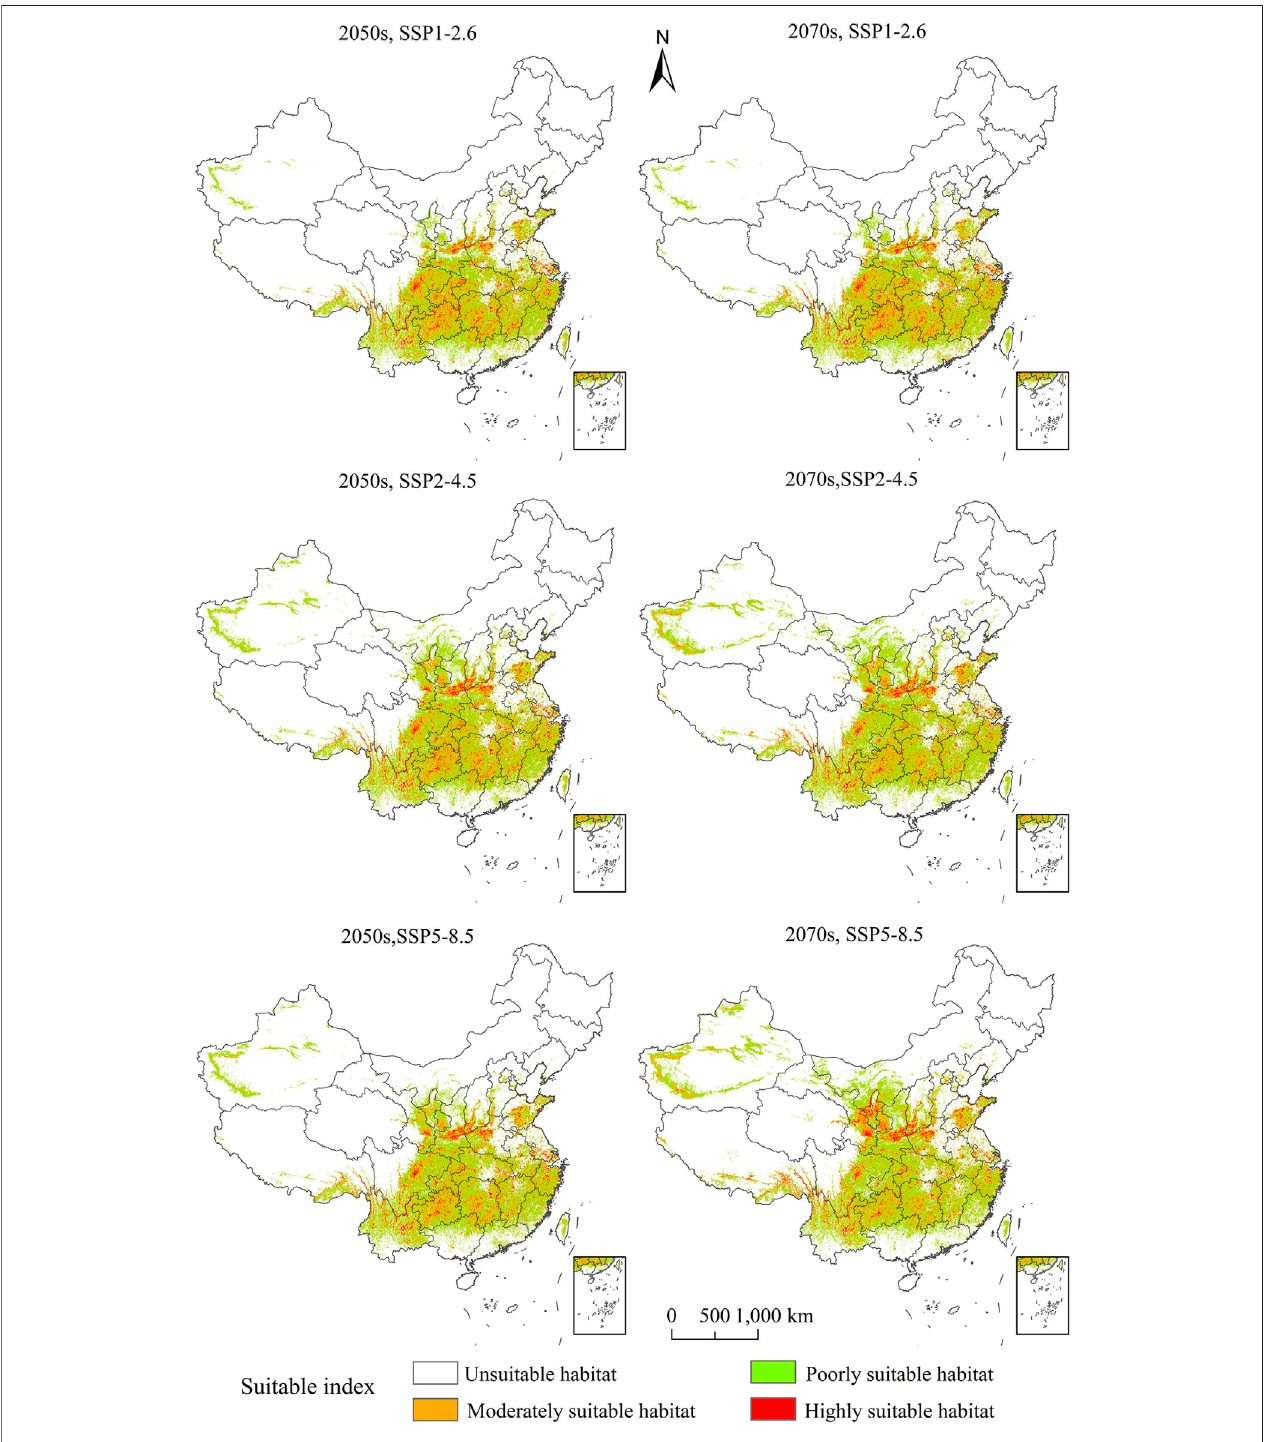
FIGURE 3 | Potential spatial distribution of Cremastra appendiculata under future scenarios of climate change.